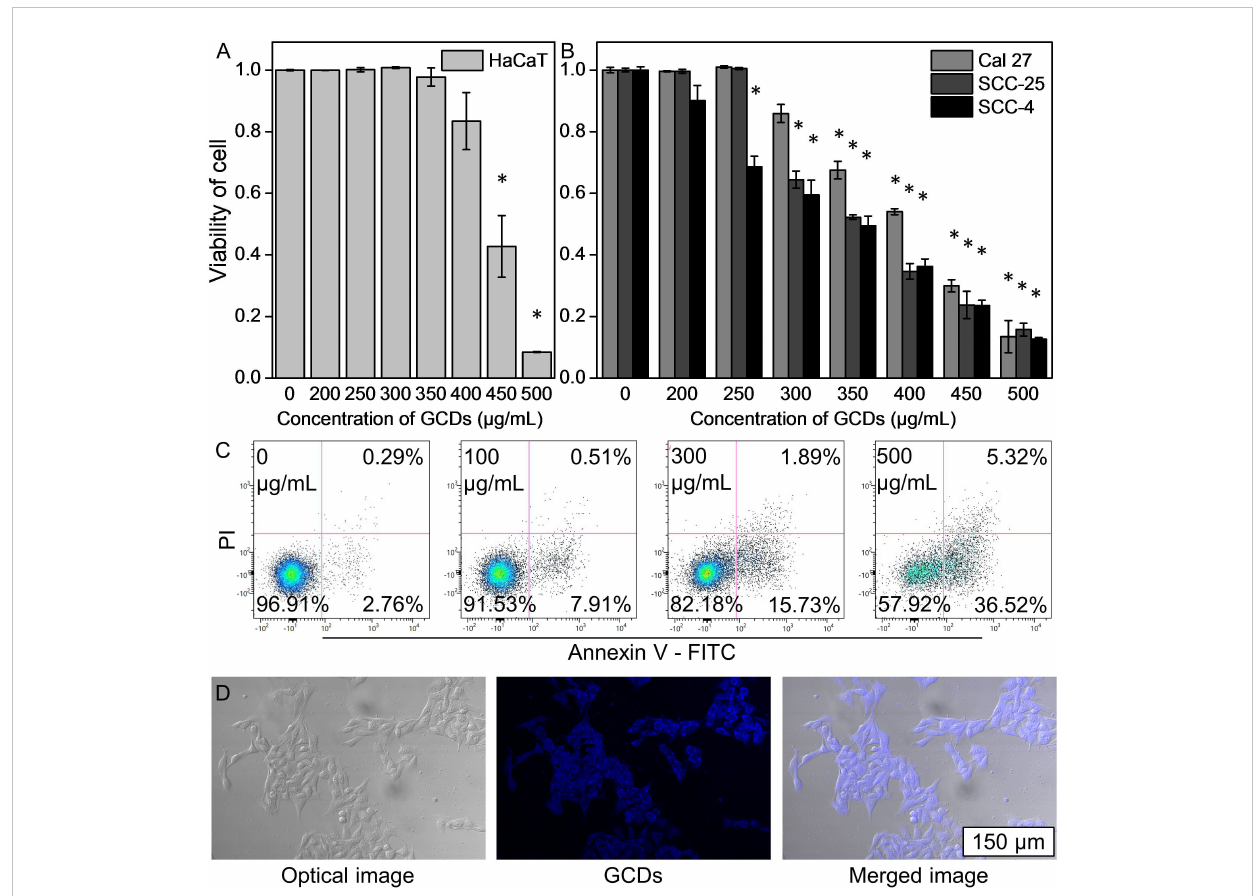
FIGURE 2 Biocompatibility and cell imaging of ginseng-based carbon dots (GCDs). (A) Cell counting kit-8 (CCK-8) assay of normal immortalized keratinocytes (HaCaT cells) treated with GCDs with different concentrations from 0 to 500 m g/mL. (B) CCK-8 assay of squamous cell carcinoma cell lines (Cal-27, SCC-25, and SCC-7) treated with GCDs with different concentrations from 0 to 500 m g/mL. (C) Apoptosis assay by fl ow cytometry in Cal-27 cells treated with different concentrations of GCDs from 0 to 500 m g/mL. (D) Cal-27 cells were treated by GCDs (300 m g/mL) by fl uorescence microscopy. Data are presented as mean ± SD from three experiments. *